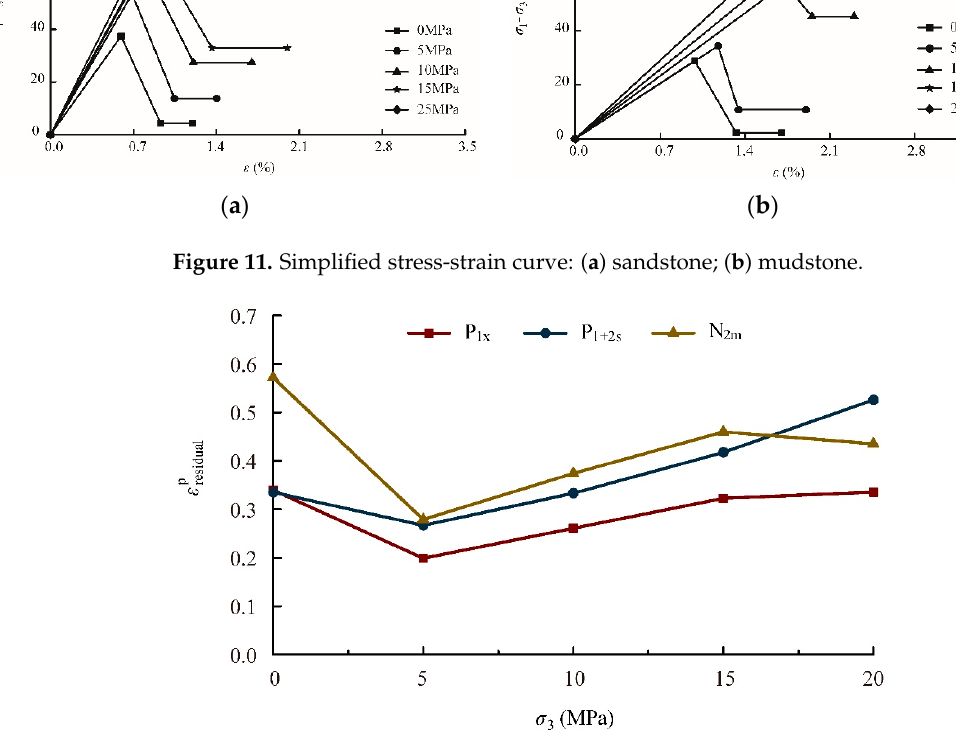
Figure 12. Schematic diagram of the relationship between the residual critical plastic strain and con- fi ning pressure.